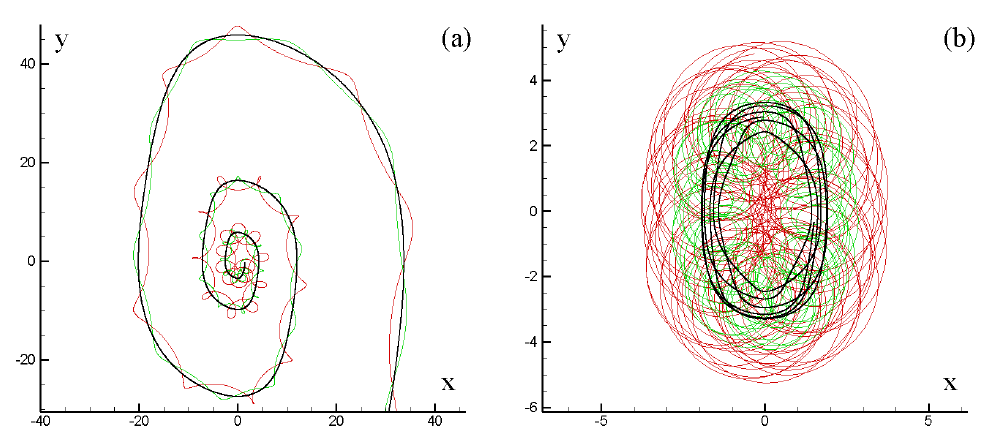
Figure 20. The trajectories of two singular vortices (thin lines) and their vorticity centre (bold line) in the case of: ( a ) parametric instability manifestation; and ( b ) no parametric instability.